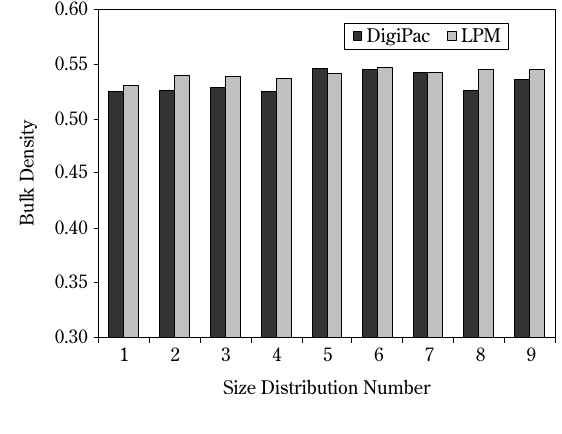
Fig. 7 Comparison of measured and simulated packing densities for PWD1 to PWD8.